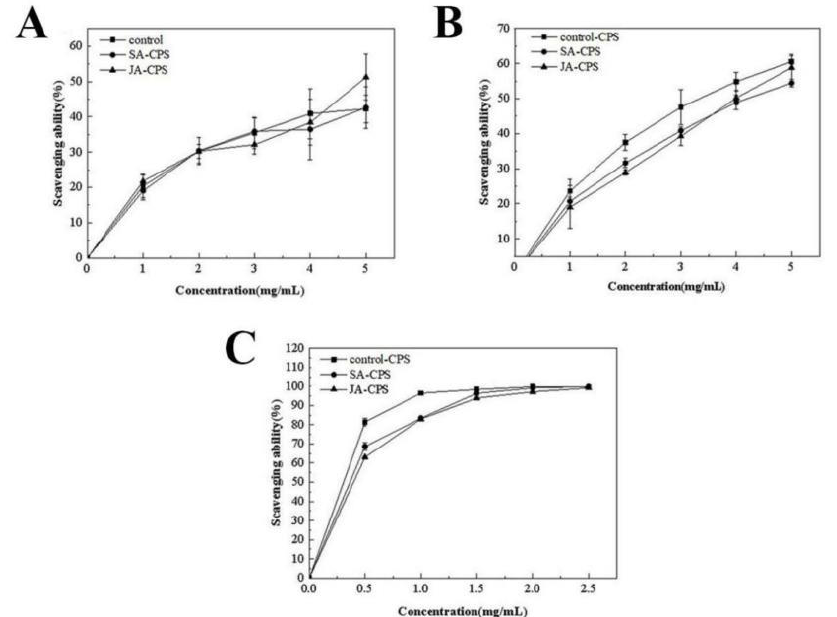
Figure 3. Antioxidant activities including the DPPH radical scavenging activity ( A ), the hydroxyl radical scavenging activity ( B ), and the ABTS + radical scavenging activity ( C ) of the control-CPS, SA-CPS, and